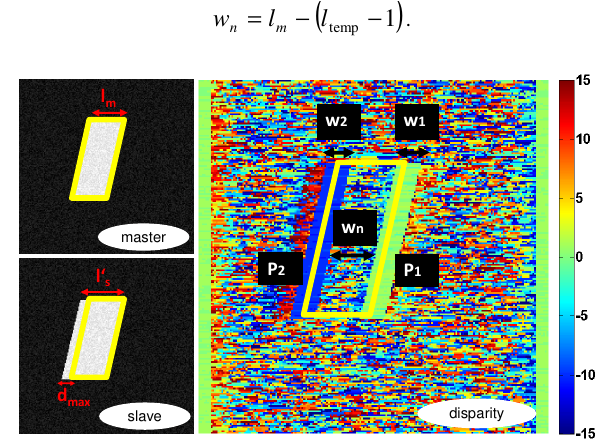
Figure 4 underlines this conclusion for both configurations: the